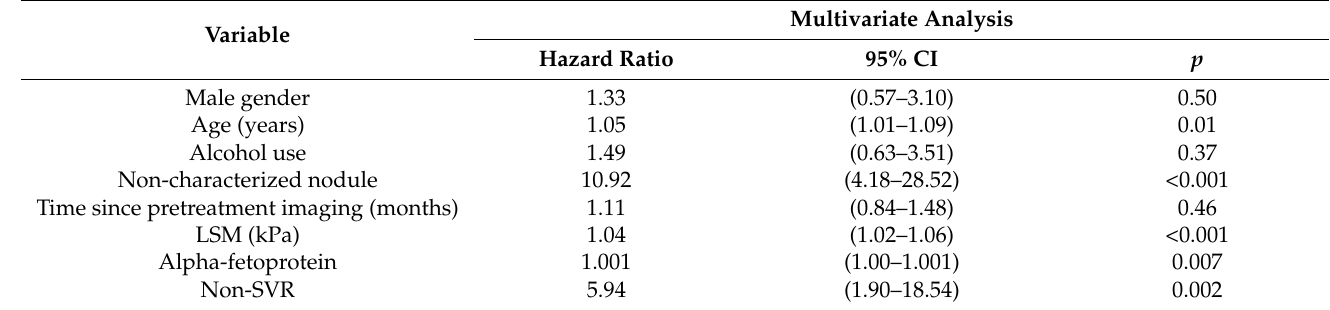
Table 3. Multivariate Cox proportional hazard regression analysis of variables associated with the risk of developing hepatocellular carcinoma after the start of DAA treatment (N =